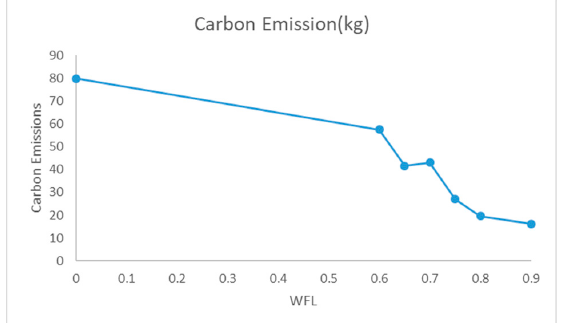
Figure 3. Caron Emissions at Different WFLs.